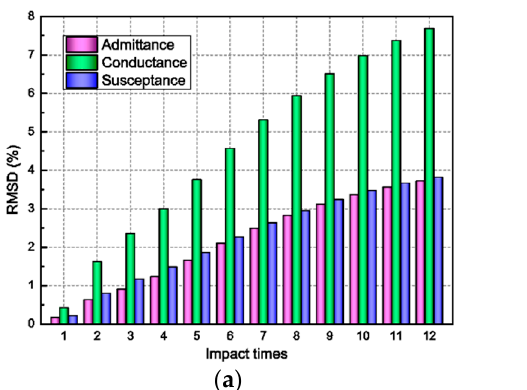
( b ) Figure 7. Damage volume ratio of concrete beam: ( a ) global damage ( d > 0); and ( b ) local damage ( d > 0.7). 4.4. Empirical Fitting Curves for Predicting Damage Levels All of these parameters’ variations and analyses in the previous section demonstrate the impact damage evolution to some extent. However, the results from the conductance signatures are, so far, qualitative. To account for the variations in the admittance curves during the repeated impact loading, the RMSD index is applied to evaluate the impact damage quantitatively, as shown in Figure 8. For the results of PZT-F, the statistical indicator RMSD for these parameters shows a similar trend that was increasing with the repeated impact, illustrating that there was increasing damage inside